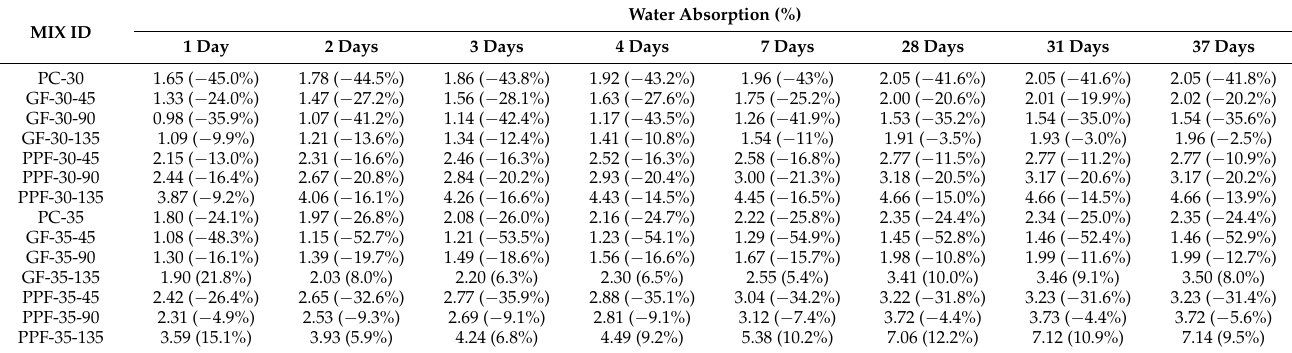
Table 9. The water absorption test results of the GFRC and PPFRC cured for three